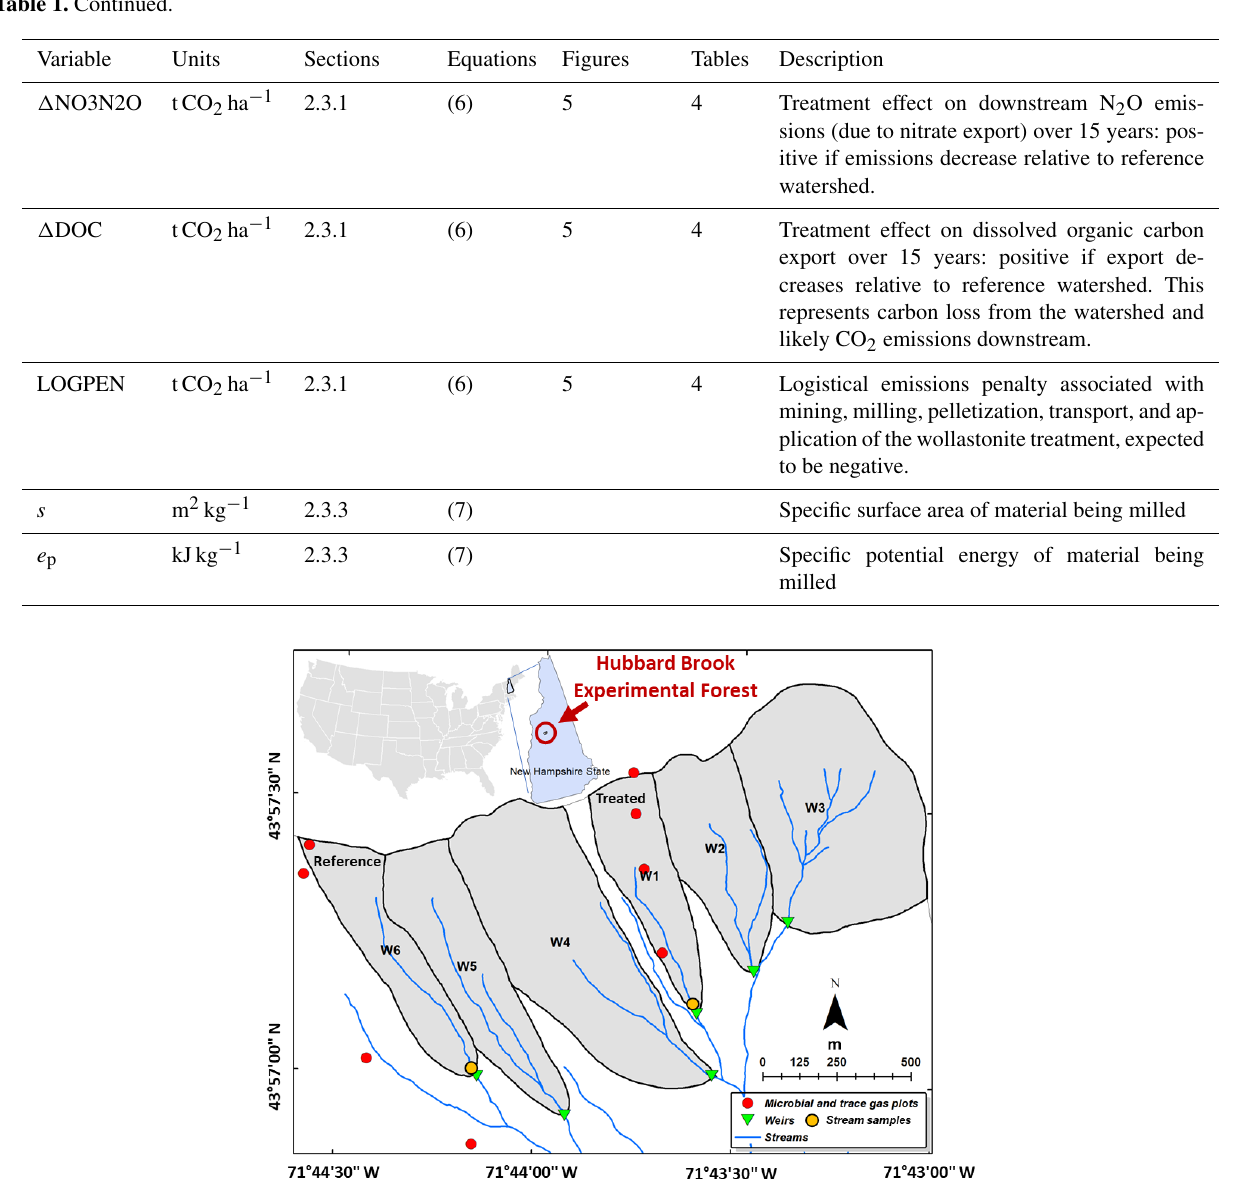
Figure 1. Location of the sampling sites and experimental watersheds. Our stream-water samples were collected just upstream of the weirs in the treated and reference watersheds (gold discs), and our trace gas samples were collected at different elevations in treated (W1) and untreated (W6) forests (red